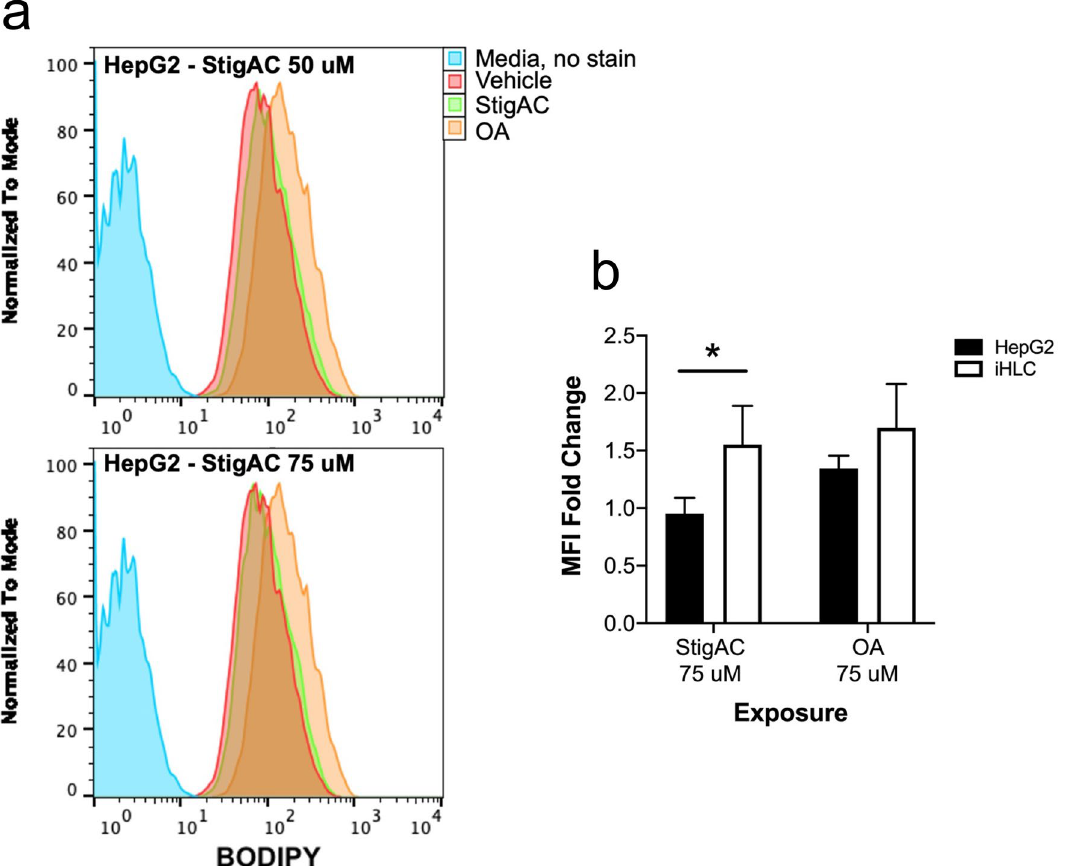
Figure 4. Lipid accumulation in stigmasterol-exposed iHLC and HepG2 cells. ( a ) Representative flow cytometry profile showing the fluorescence of BODIPY in HepG2 cells exposed to 50 μM and 75 μM of StigAC (green), compared to HepG2 cells exposed to vehicle alone (red) and the positive control HepG2 cells exposed to oleic acid (OA) (orange). ( b ) Bar graph showing the BODIPY MFI of iHLC (white) and HepG2 cells (black) exposed to 75 μM of StigAC and oleic acid, relative to the MFI of cells exposed to vehicle alone. N = 3 independent experiments in all exposures. Error bar indicates standard deviation (SD). * P -value < 0.05. StigAC, stigmasterol acetate; OA, oleic